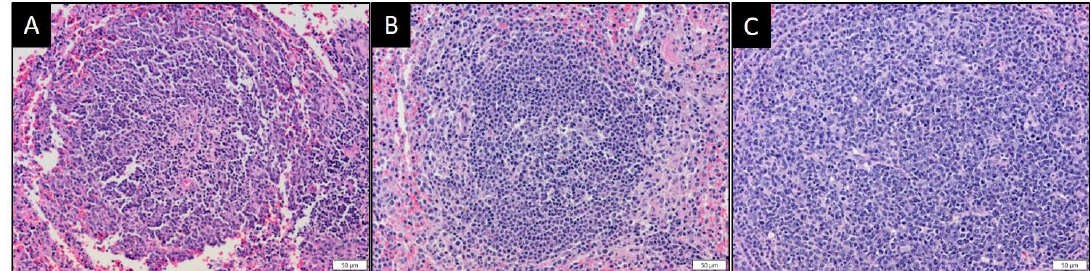
Figure 14. Representative photomicrographs of splenic lymphoid follicles from rabbits injected with ( A ) saline, ( B ) 50 pfu MYXV, or ( C ) 50 pfu MYXVorfC. Samples were collected at the time of euthanasia. Marked follicular hyperplasia was noted in rabbits infected with MYXVorfC (H&E, magnification 20× objective).